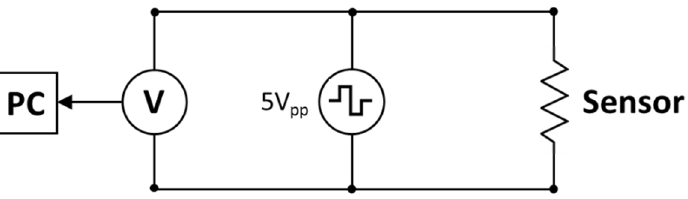
Figure 3. Electrical circuit used to record the voltage-drop measurements.